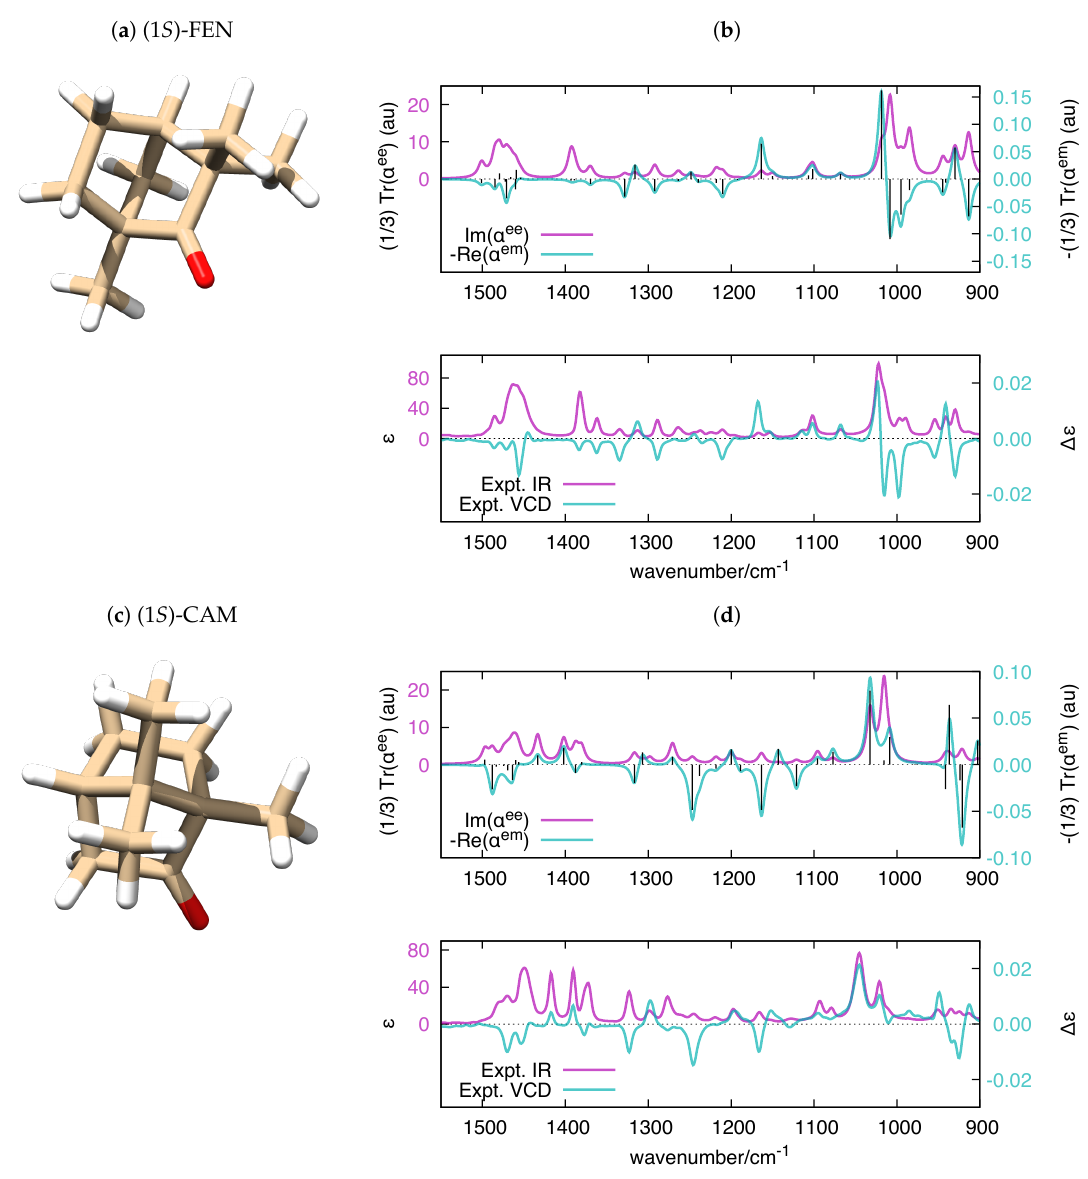
Figure 6. ( a , c ) The equilibrium structure of (1 S )-FEN and (1 S )-CAM, respectively; and ( b , d ) polar -simulated IR and VCD spectra of (1 S )-FEN and (1 S )-CAM ( Γ = 10 cm − 1 ), respectively, compared to their experimental counterparts [79]. The vertical black bars in the top panels are proportional to the rotatory strengths computed by Gaussian ( R 0 k ). To ease the comparison with the experimental data, the wavenumber axis of the simulated polarizabilities has been uniformly scaled by the empirical factor 0.98. DFT calculations were carried out at the B3LYP/aug-cc-pVTZ